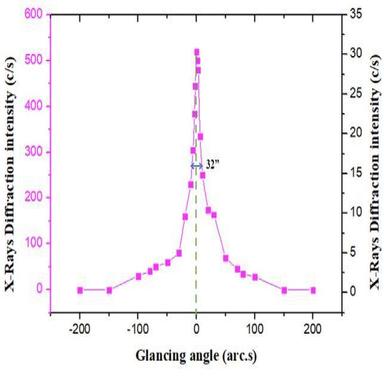
Exposed HRXRD of L-LGBCAC.